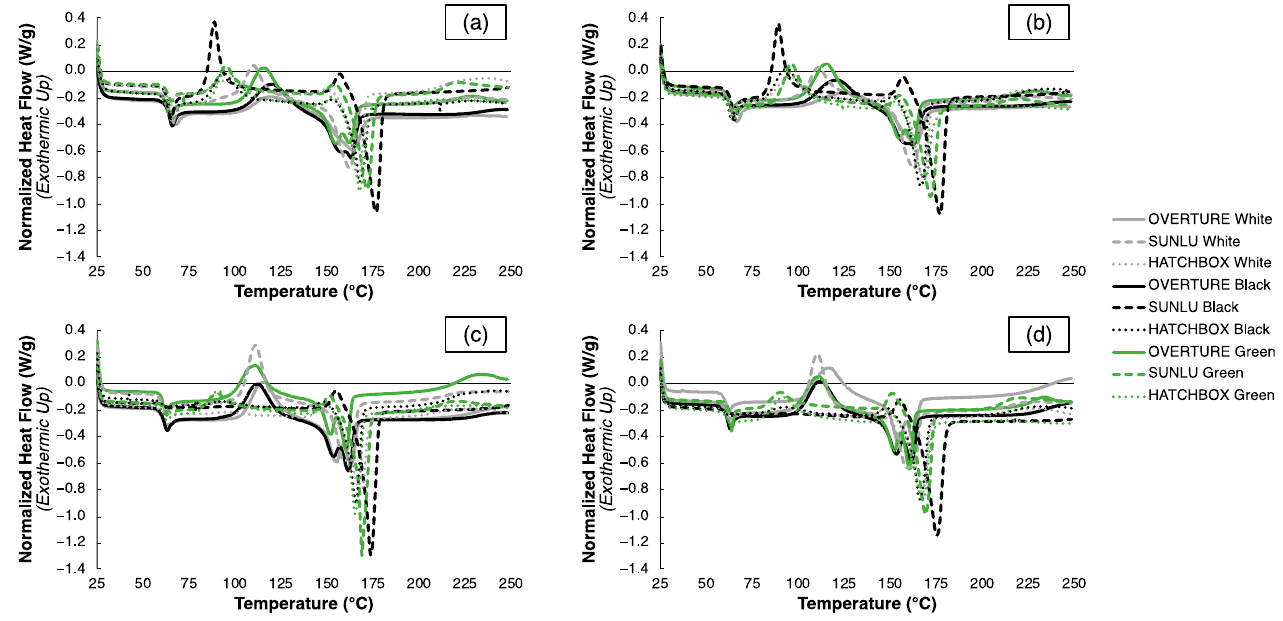
Figure 7. DSC curves upon heating for the optimal and worst-case parameter sets in the as-printed condition (( a ) and ( b ), respectively) and the annealed condition (( c ) and ( d ), respectively). Table 9. Percent di ff erences in thermal characteristics (with original units provided) between the annealed and as-printed specimens for each fi lament for both the optimal and worst-case parameter sets.